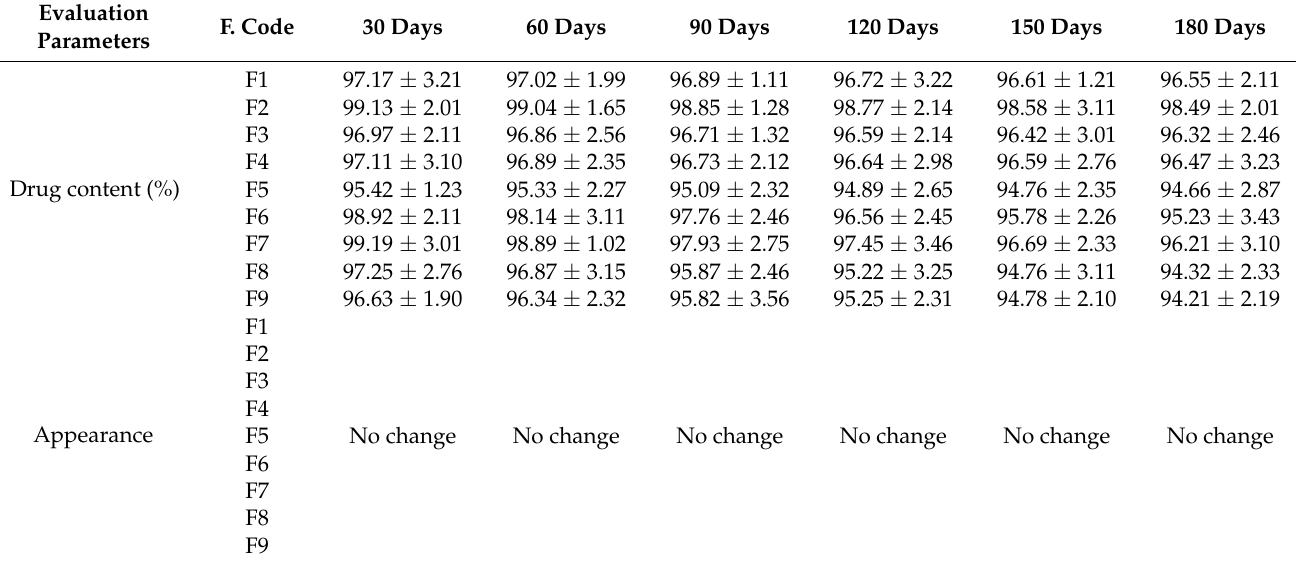
Table 3. Stability studies of MTX-loaded transdermal patches (F1–F9), Data were expressed as mean ± SD, n = 3. Significant compared to formalin ( p <